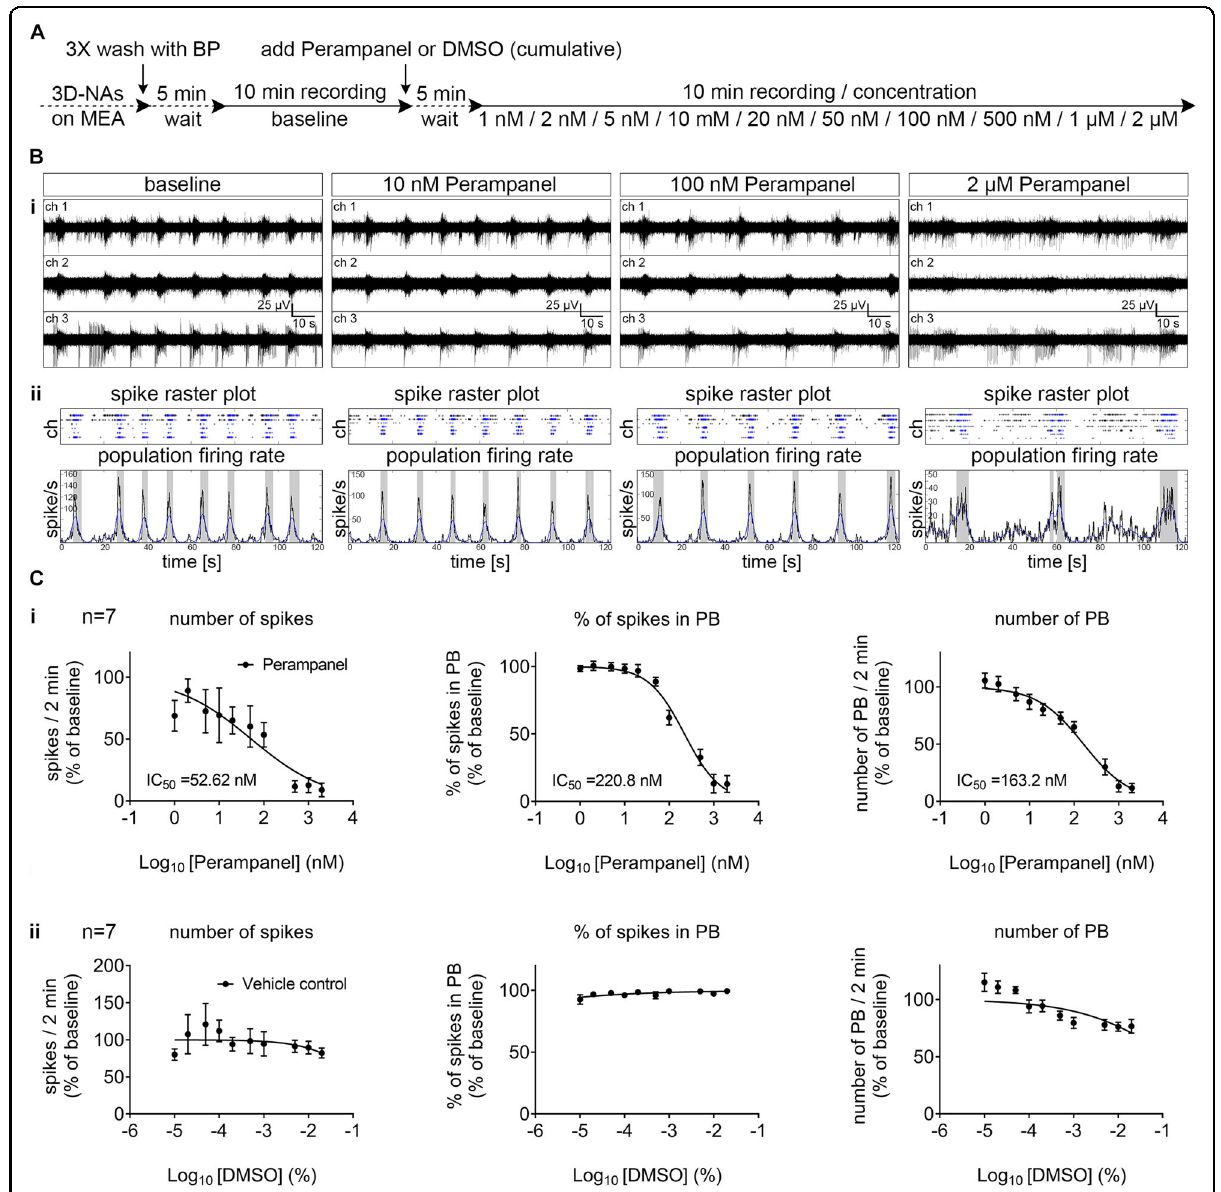
Fig. 4 Perampanel suppresses the synchronous neuronal activity in concentration-dependent manner. A Schematic representation of the applied protocol to evaluate the cumulative dose – response of hiPSC-derived highly synchronous neuronal networks (day 30 after seeding) to the AMPA-receptor inhibitor Perampanel. B , i Representative examples of MEA-recordings (three individual channels are shown) with their corresponding. B , ii Spike raster plot and population fi ring rate diagrams showing the suppression of synchronous population bursting by increasing concentrations of Perampanel. C , i Dose – response curves showing the suppression of network parameters (number of spikes, % of spikes organized in population bursts-PB and number of PB) with increasing concentrations of Perampanel. The data is shown as % of change compared to baseline and represents the mean ± standard error of the mean values. The IC 50 values are given, n = 7, N = 2. C , ii Dose – response curves showing the stable network activity parameters with the application of DMSO vehicle control, n = 7, N =